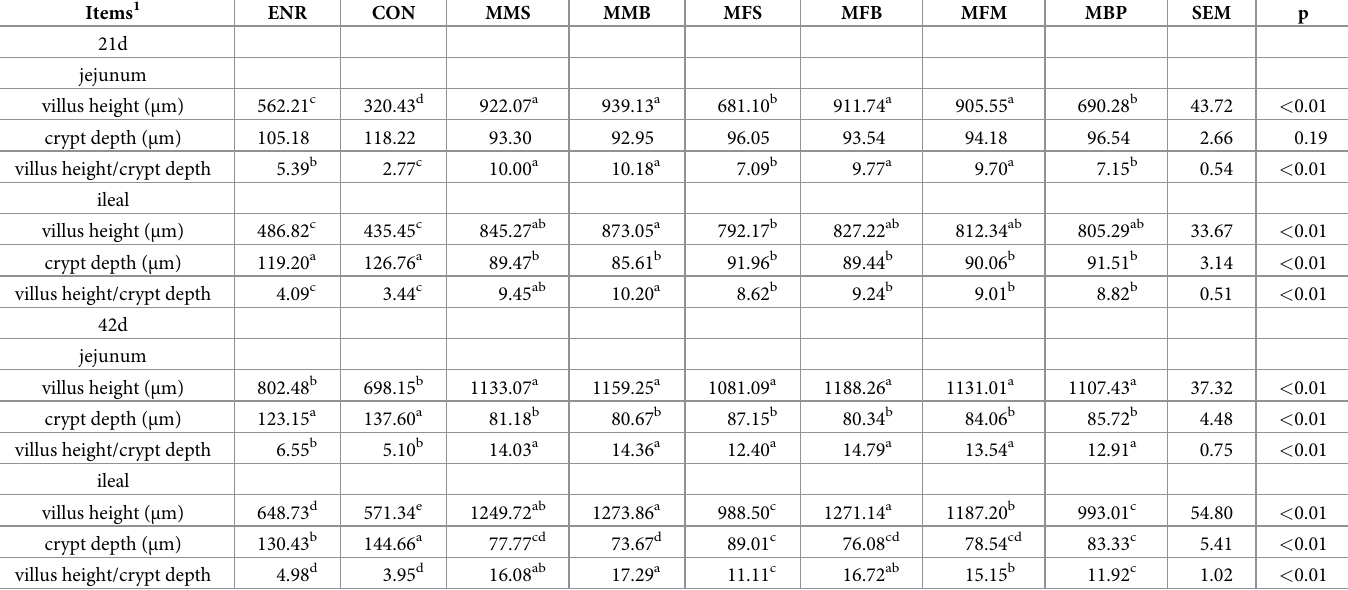
Table 5. Effects of dietary nonantibiotic alternative growth promoter combinations on ileal and jejunum histomorphological parameters of broilers at 21 and 42 days.